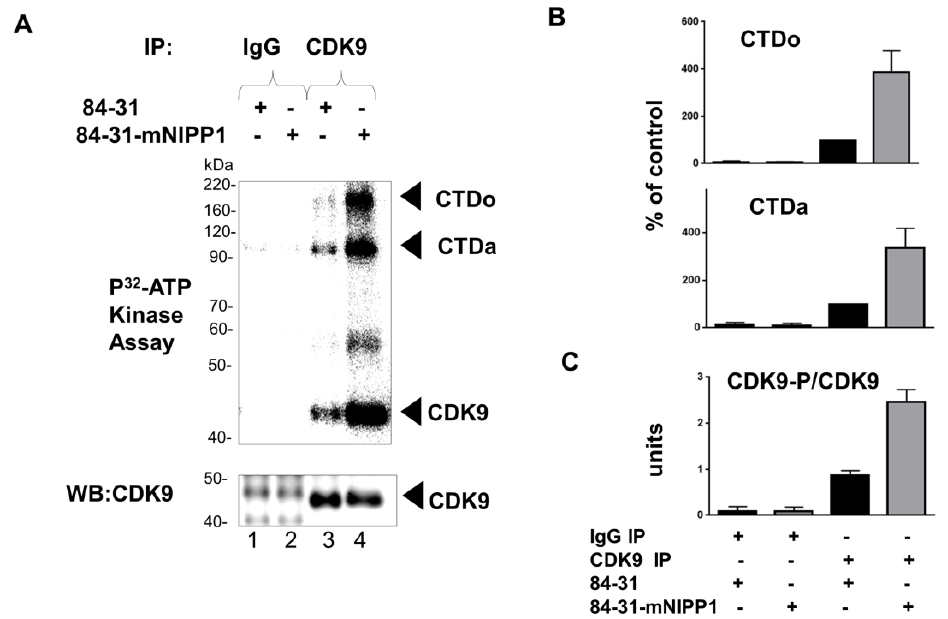
Figure 5. Stable expression of mNIPP1 increases enzymatic activity of CDK9. ( A ) Analysis of CDK9 activity and phosphorylation. CDK9 was immunoprecipitated from 84-31 or 84-31-mNIPP1 cells with either anti-CDK9 polyclonal antibodies (lanes 3 and 4) or with pre-immune serum (lanes 1 and 2). A portion of the immunoprecipitation product (IP) was resolved on 10% SDS-PAGE and immunoblotted with anti-CDK9 antibodies (WB). The remaining IP was supplemented with ( 32 P) γ -ATP and incubated with GST-CTD. Reactions products were resolved on 10% SDS-PAGE and visualized using PhosphorImager Storm 860 (Molecular Dynamics). The positions of the CDK9, hypo- (CTDa) and hyper- (CTDo) phosphorylated C -terminal domain of RNAPII are indicated by arrowheads; ( B , C ) Quantification of phosphorylated CTDo and CTDa bands and the CDK9 phosphorylated band from panel A. Phosphorylated CDK9 was normalized to non-phosphorylated CDK9.